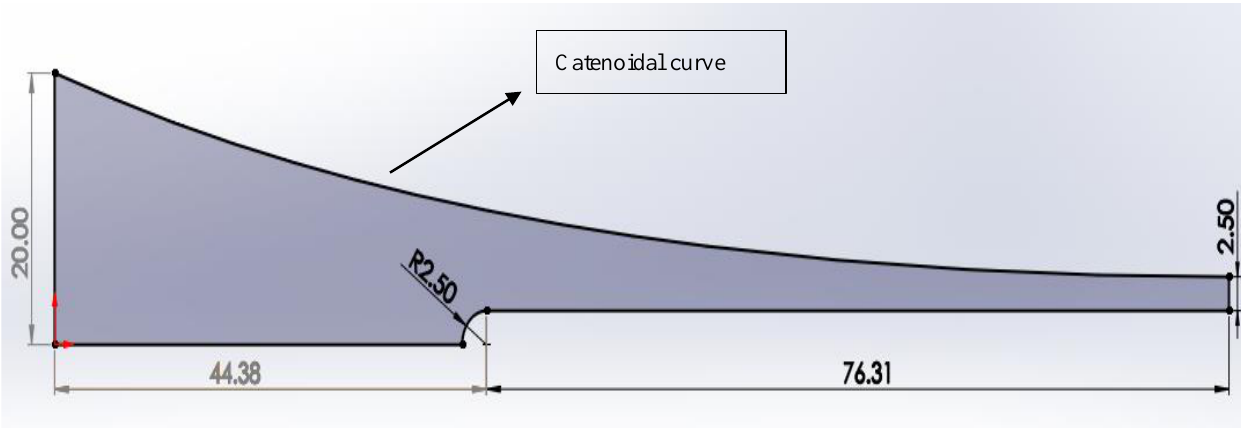
Figure 2. Detailed 2D sketch for catenoidal horn